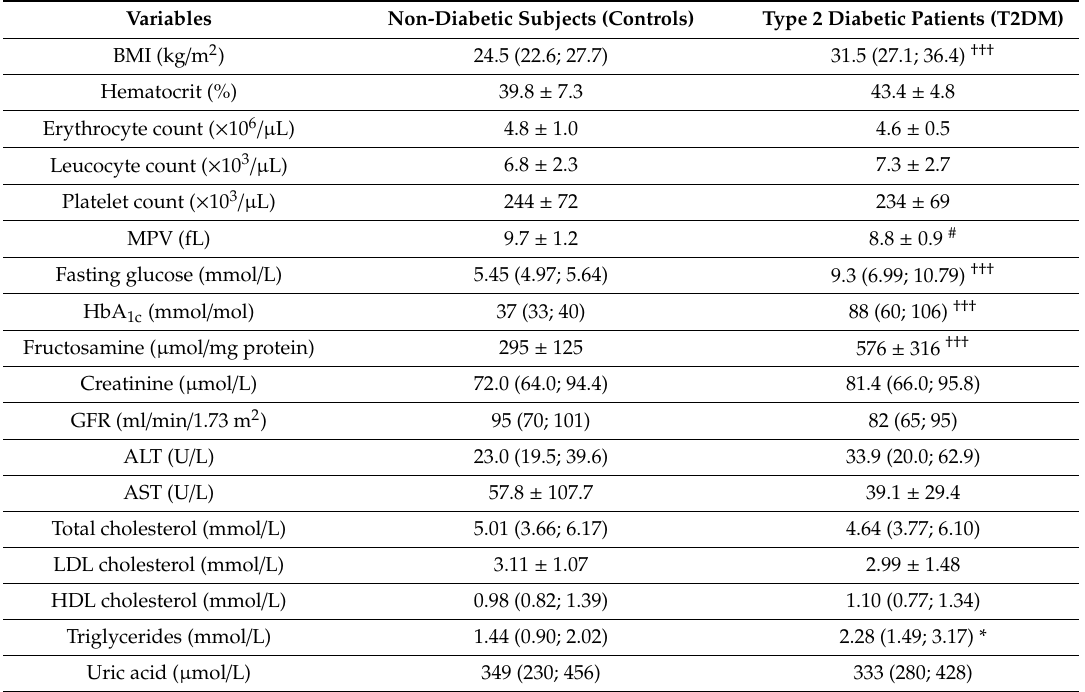
Table 2. Characteristics of T2DM patients and control